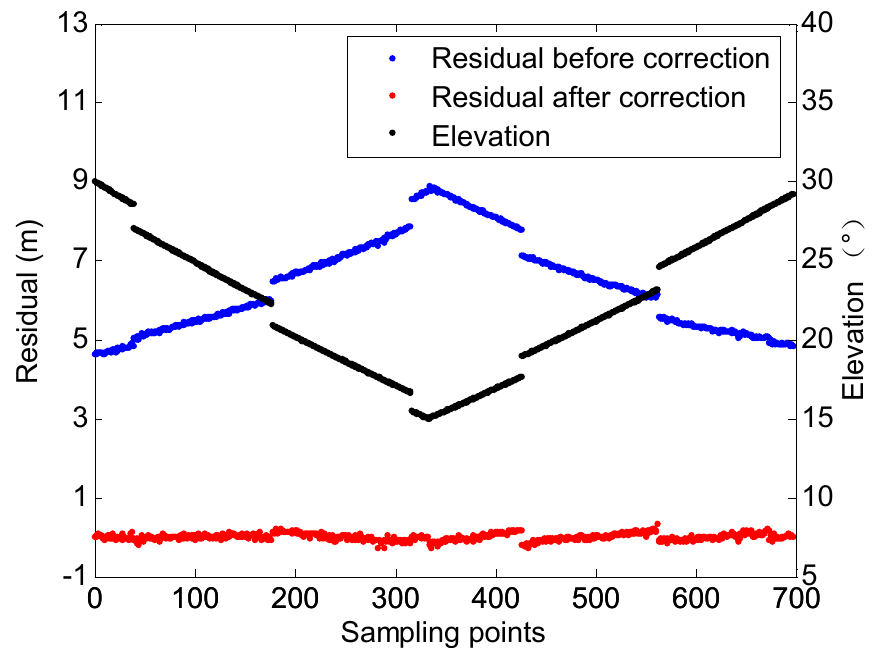
Figure 5. Analysis of ionospheric range error correction accuracy.